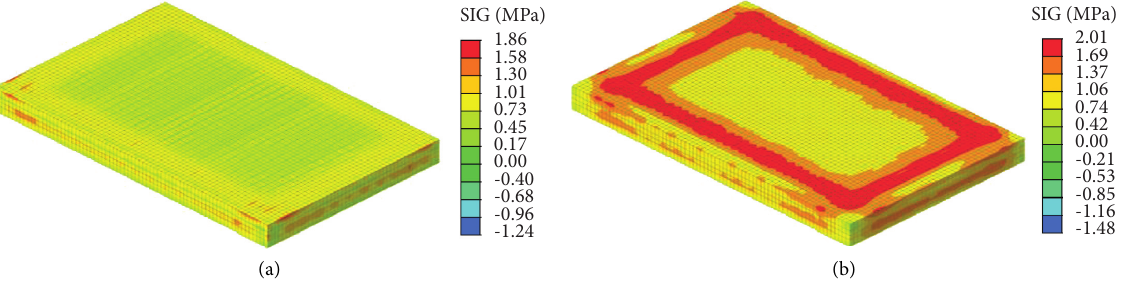
Figure 13: Time-history curve of main tensile stress in the first layer of